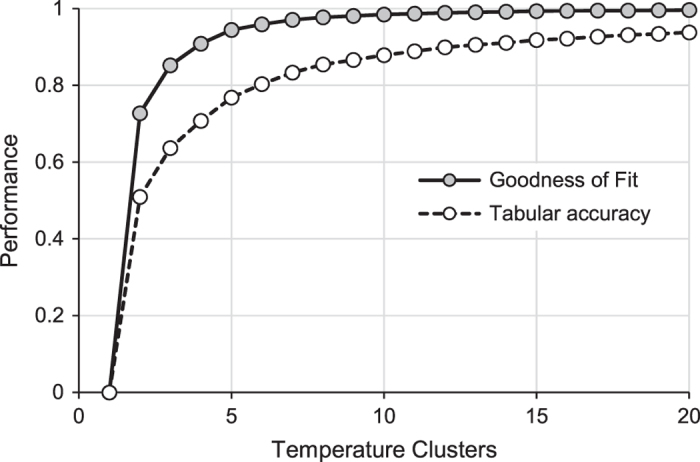
Thresholds for determining partitions between temperature classes.Goodness-of-fit and tabular accuracy for different numbers of temperature clusters using Jenks method.